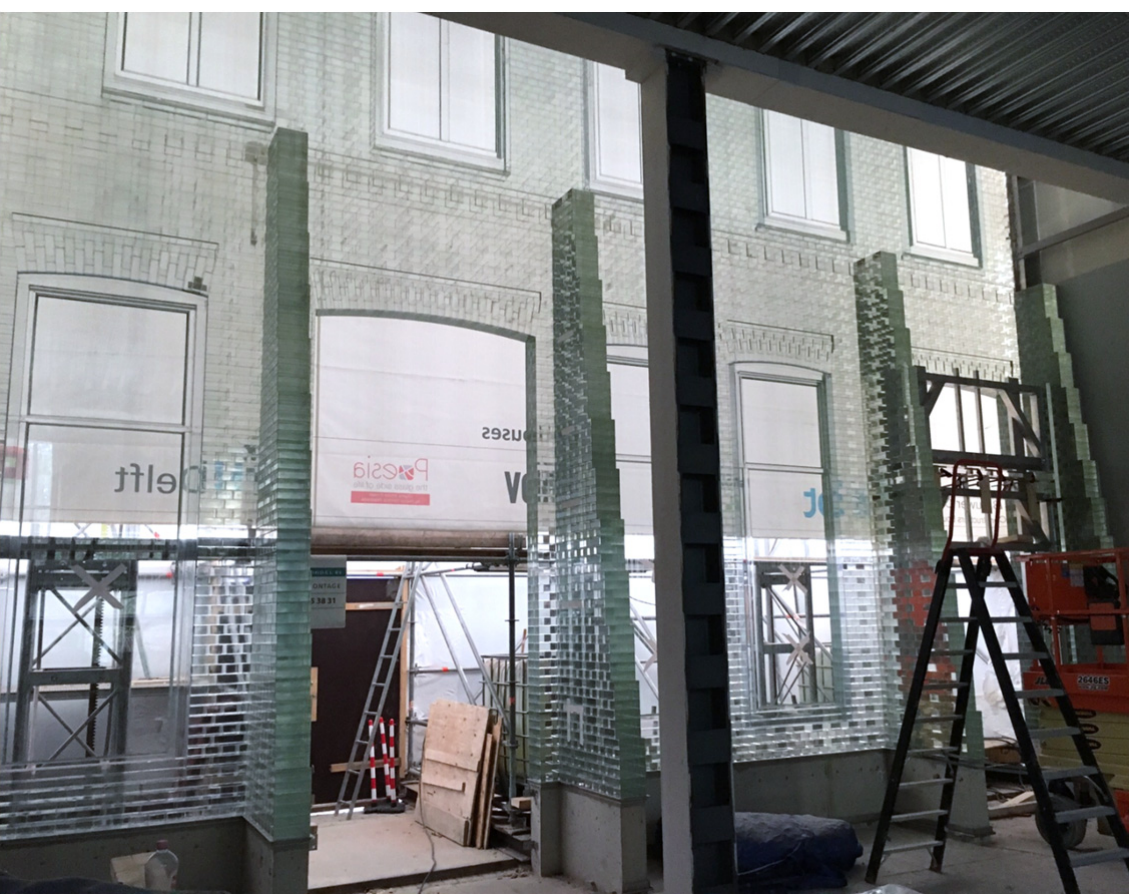
Fig. 16 The glass masonry